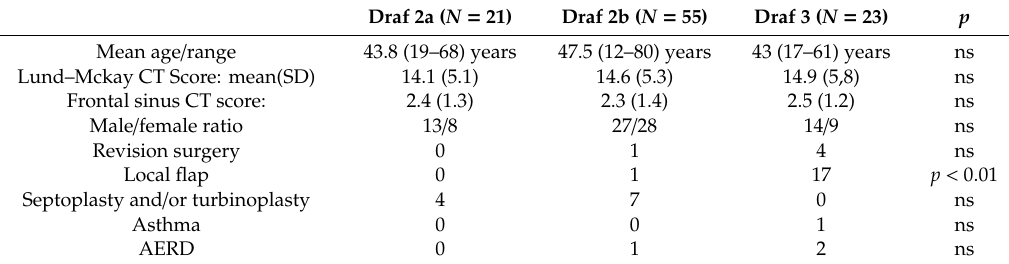
Table 1. Descriptive statistics per Draf procedure.